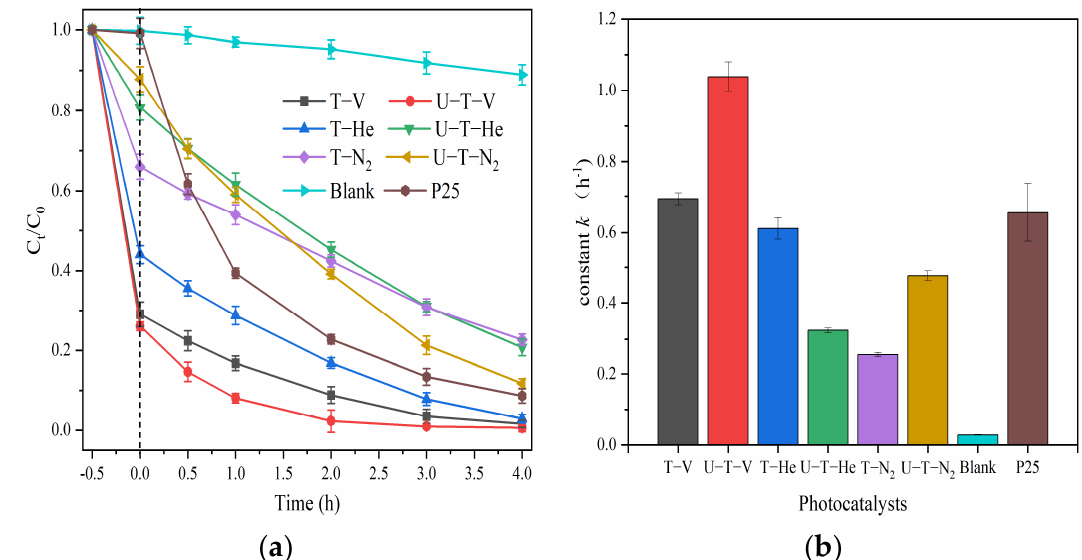
Figure 6. ( a ) Photocatalytic degradation activity for MB by the as-prepared TiO 2 samples under simulated solar light irradiation; ( b ) Constant k of the fitted Pseudo-first-order dynamic curves of photocatalytic degradation for MB.